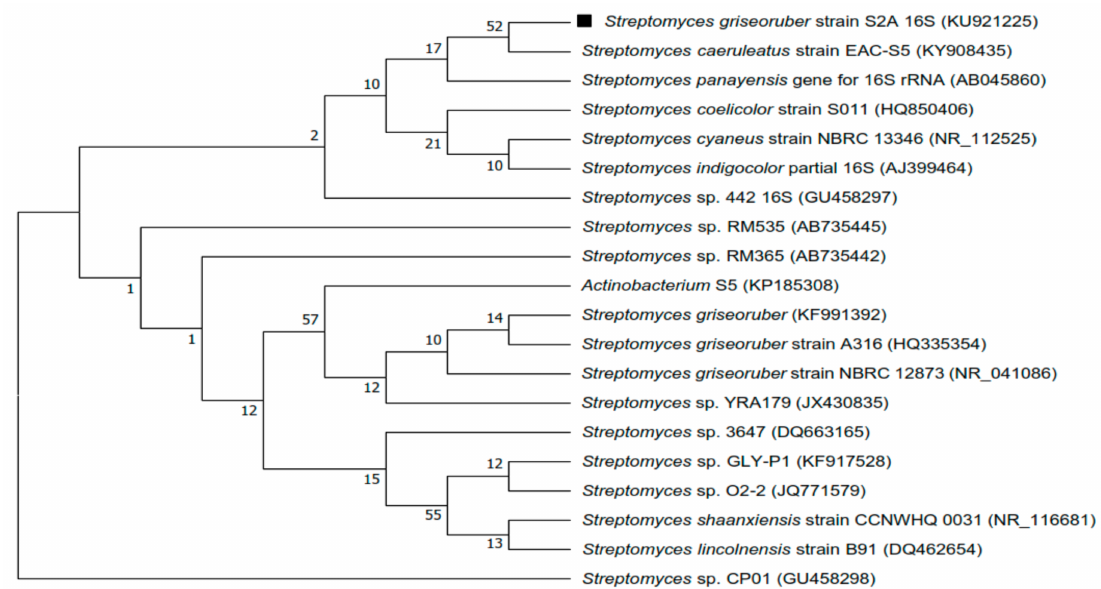
Figure 2. Phylogenetic tree of Streptomyces sp.S2A and the relationships with the closest species based on 16S rRNA gene sequencing using the neighbor-joining method.